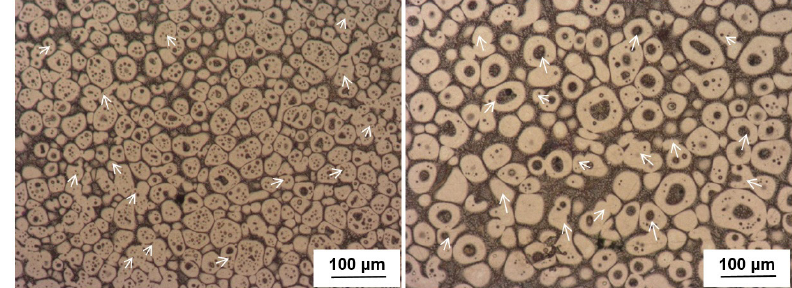
Figure 14. Coalescence of pure ZA27 alloys during the heat treatment (a) 15 min and (b) 45 min. Table 2. Experimental mean values of ZA27 alloys. TIME